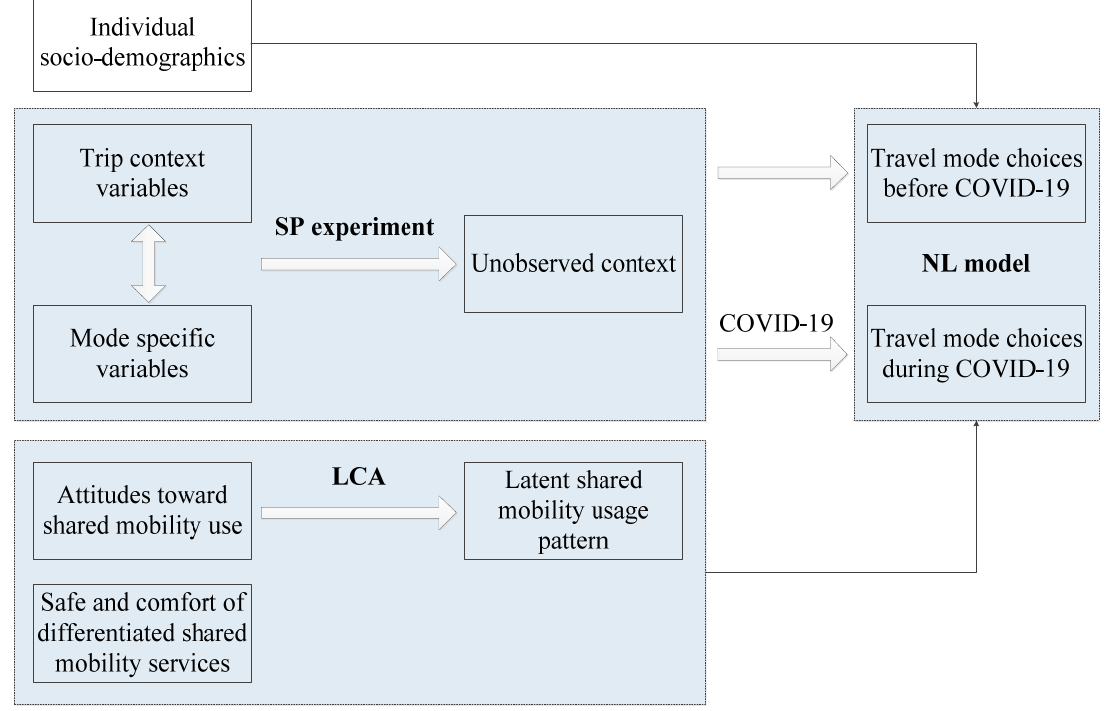
Figure 1. Research framework.